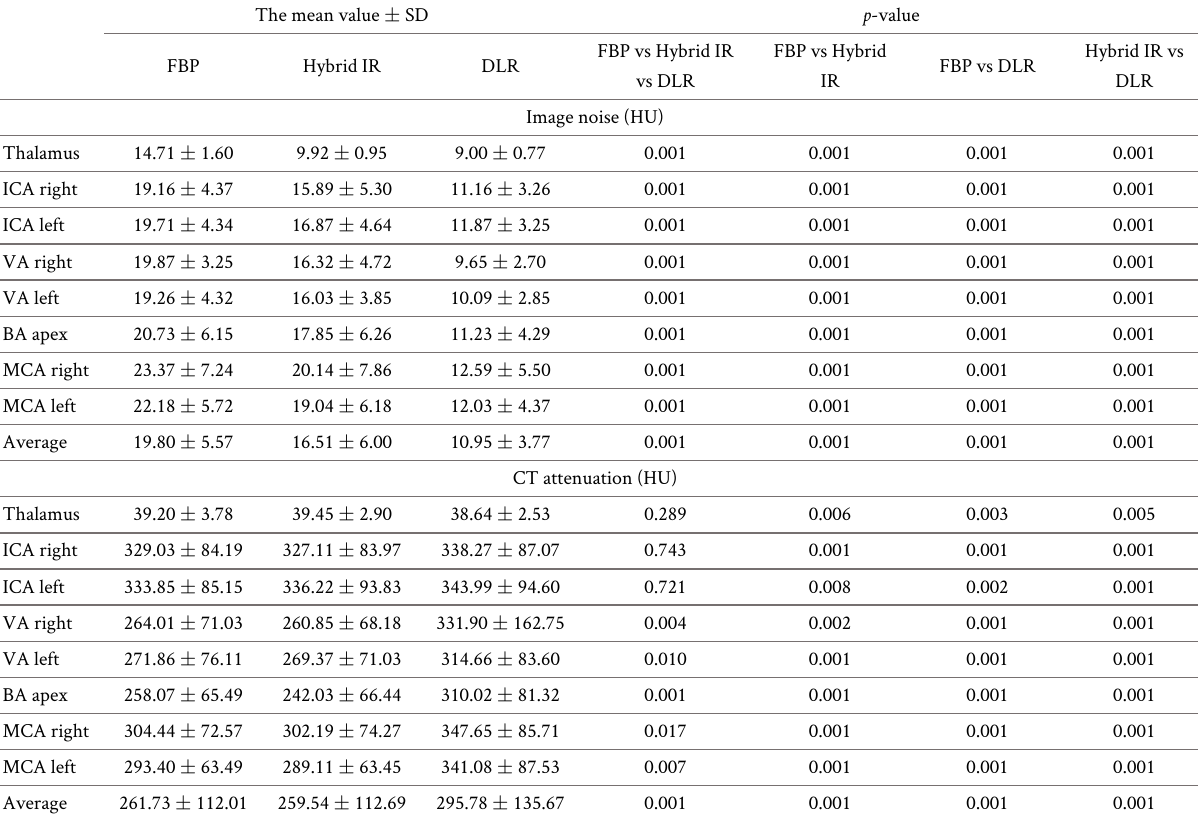
Table 1. Results of image noise and